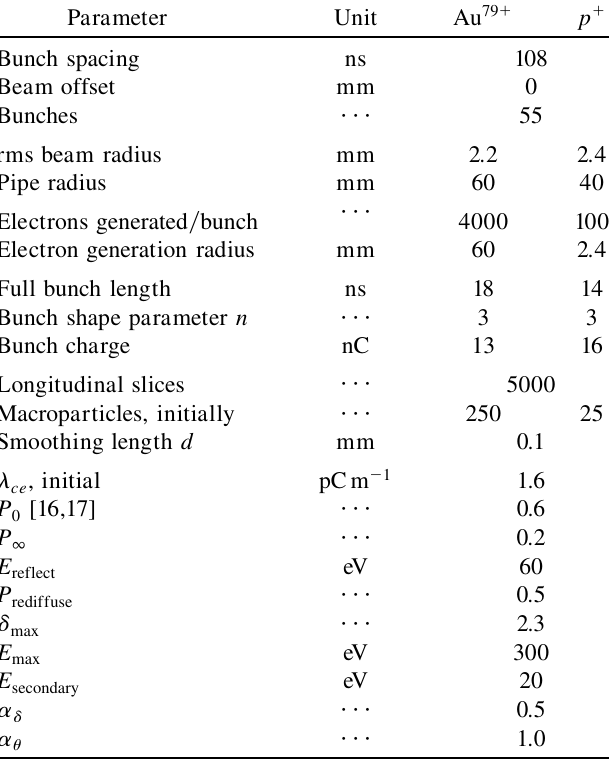
TABLE IV. List of input parameters for electron cloud sim- ulations. For gold and proton beams reference cases are pre- sented with design intensity and twice the design bunch